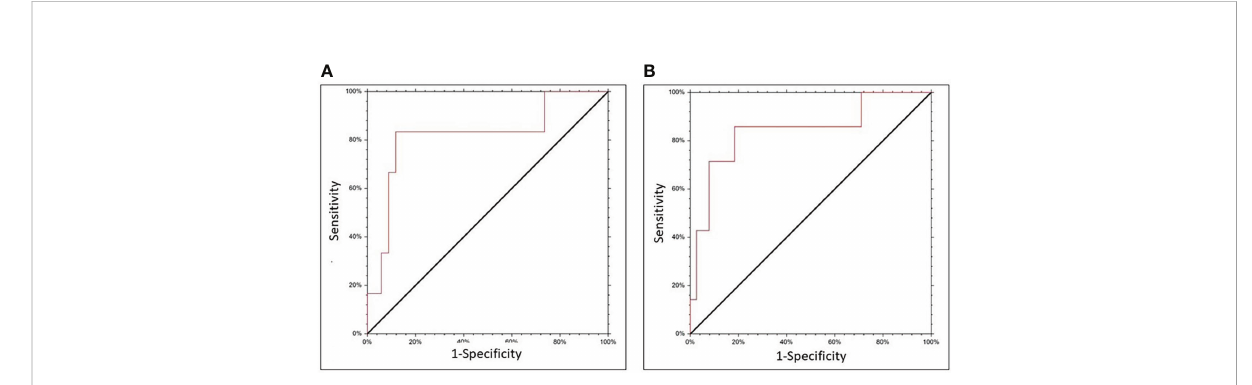
FIGURE 2 ROC curve for WT1 expression on CD34 selected cells (A) or unfractionated BM cells (B) , and relapse.